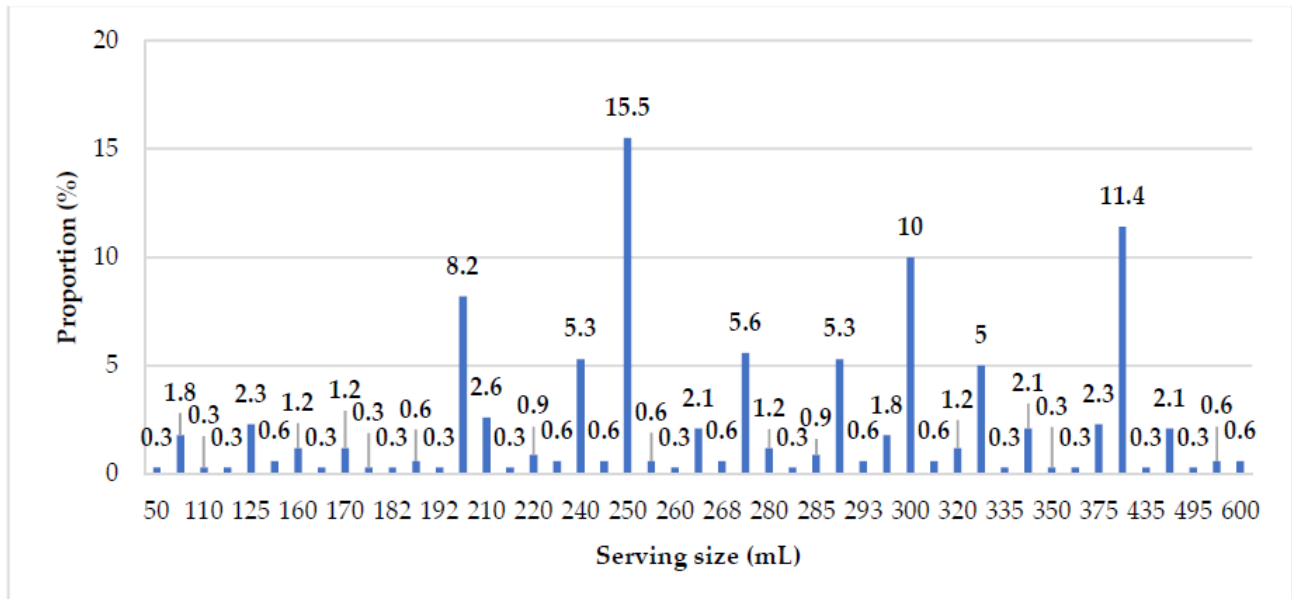
Figure A1. Distribution of serving sizes for sugar-sweetened beverages ( N = 341).